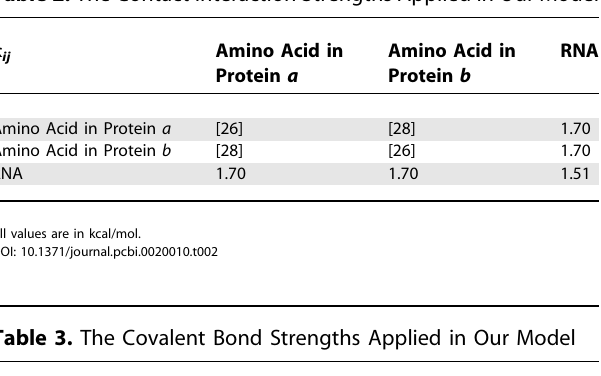
Table 3. The Covalent Bond Strengths Applied in Our Model Backbone Type KT